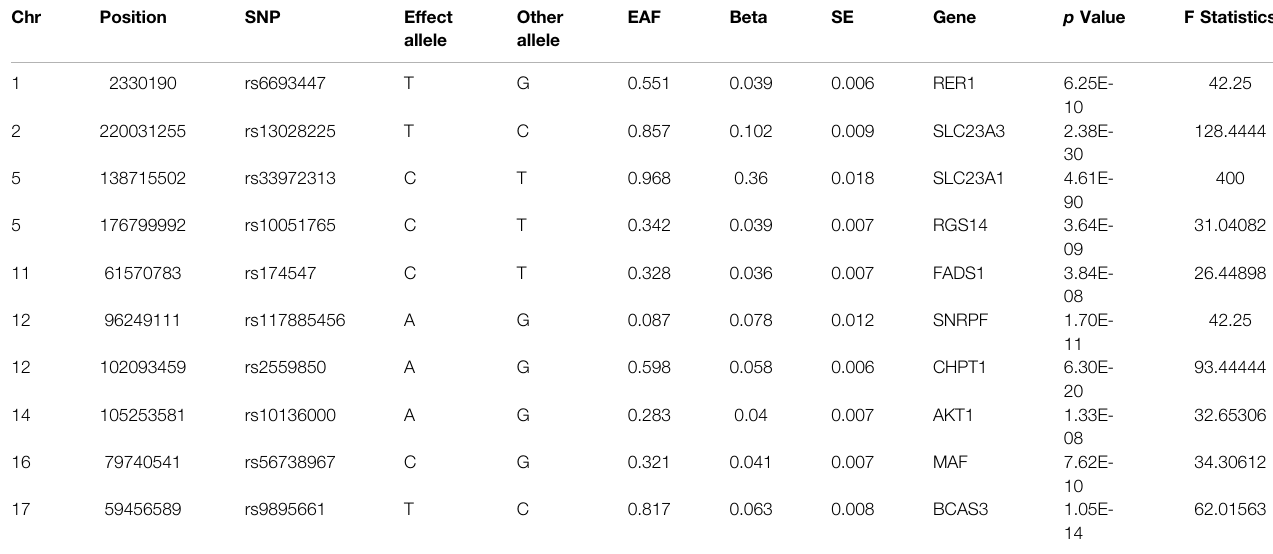
TABLE 1 | Vitamin C SNPs used to construct the instrument variable.